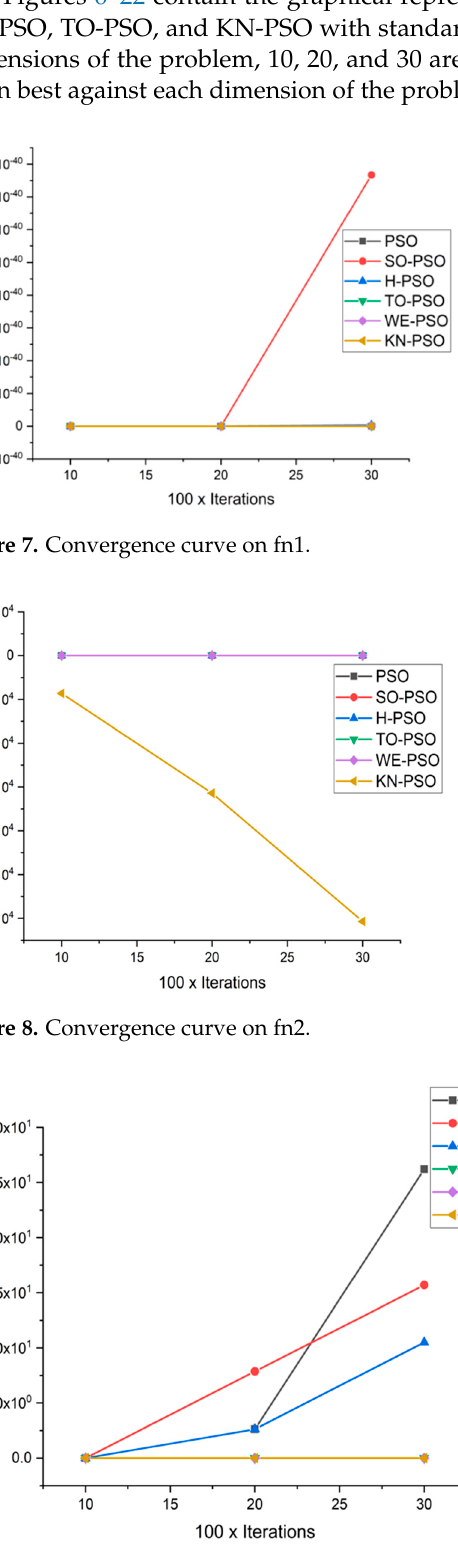
Figure 9. Convergence curve on fn3.